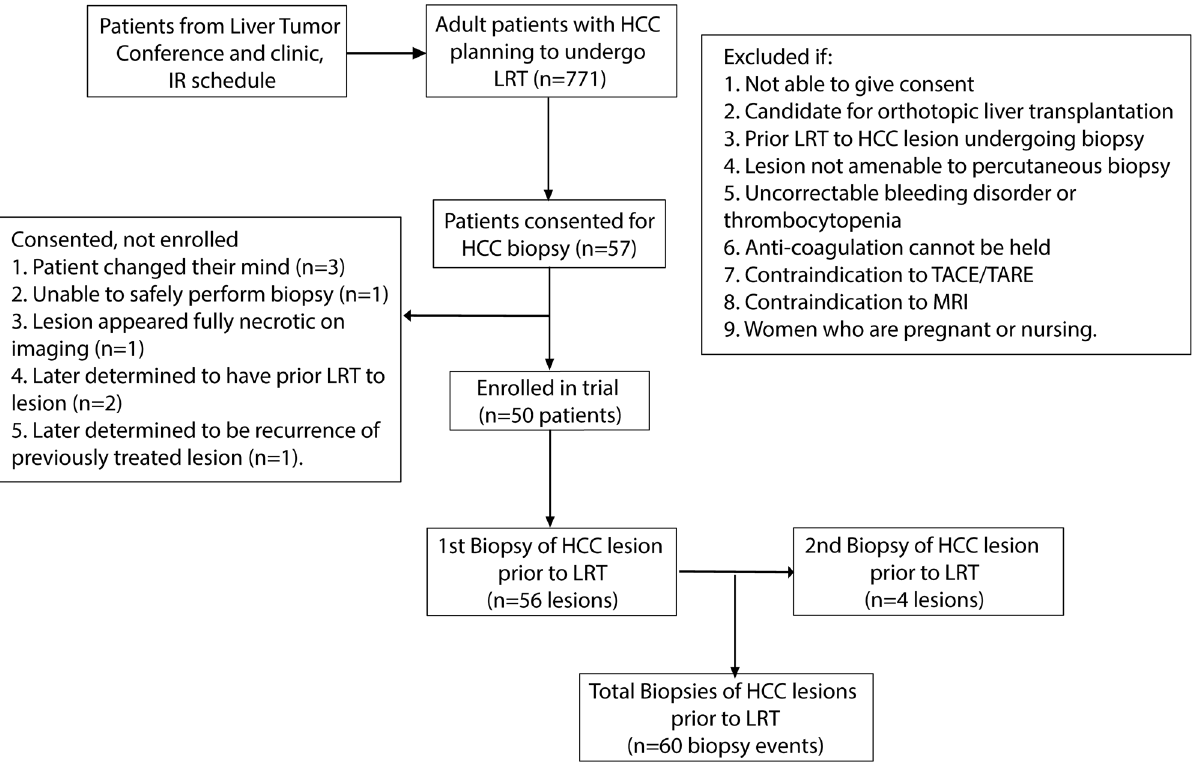
Figure 1. Patient Enrollment. Schematic demonstrating patient enrollment in the prospective clinical